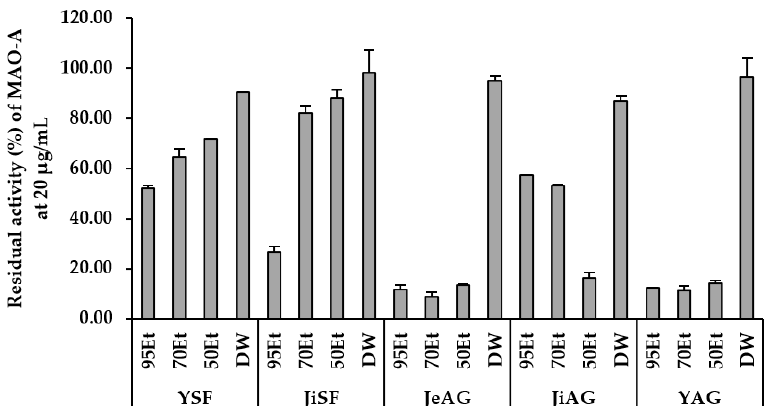
Figure 2. Inhibition of MAO-A by the extracts. The different concentrations of DMSO were used as solvent for dissolving extracts due to their solubility, i.e., all the 95Et extracts in 100%; YSF-70Et, YSF-50Et, JiAG-70Et, JiAG-50Et, JeAG-70Et, and JeAG-50Et in 80%; JiSF-70Et, YAG-70Et, and YAG- 50Et in 50%; and JiSF-50Et in 30% DMSO. All the DW extracts were dissolved in water. Activity of MAO-A was observed as the procedure described in the ‘Materials and Methods’ section, by adding the extract ( 20 μg/mL ) to the reaction mixture containing 0.06 mM of kynuramine. In the MAO-B inhibition study, YSF-95Et, YSF-70Et, JiAG-95Et, and YSF-50Et showed effective inhibitory activity, with residual activities of 6.43%, 20.79%, 29.07%, and 42.08%,